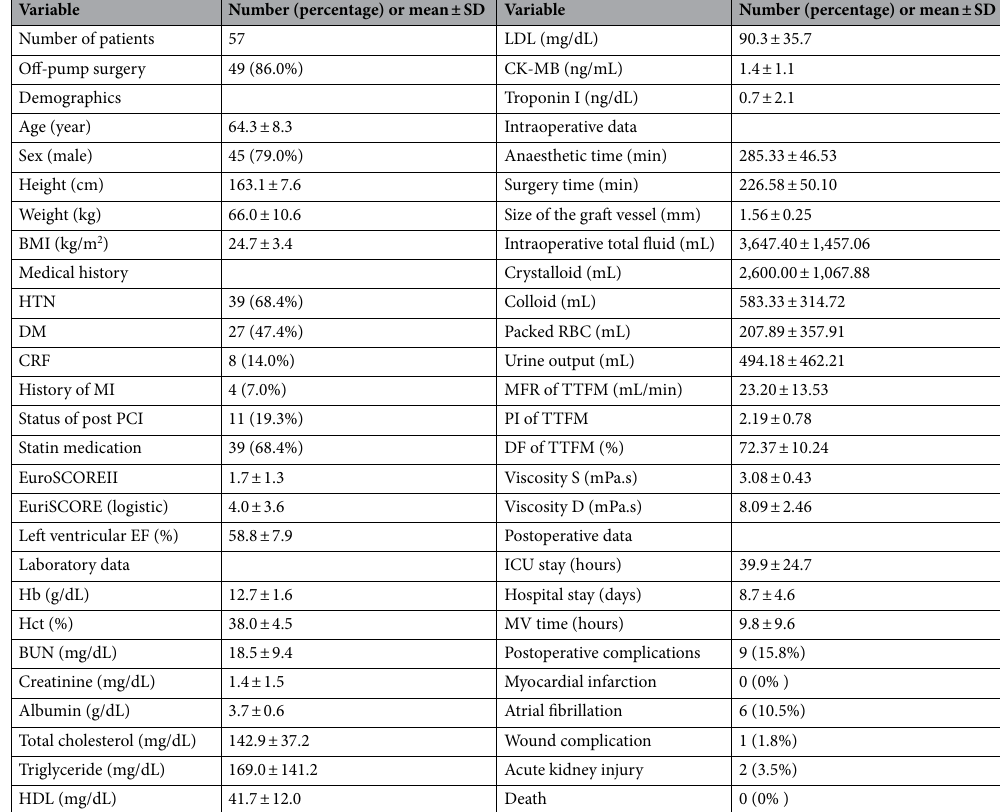
Table 1. Baseline clinical characteristics and perioperative data of the enrolled patients. SD standard deviation, BMI body mass index, HTN hypertension, DM diabetes mellitus, CRF chronic renal failure,